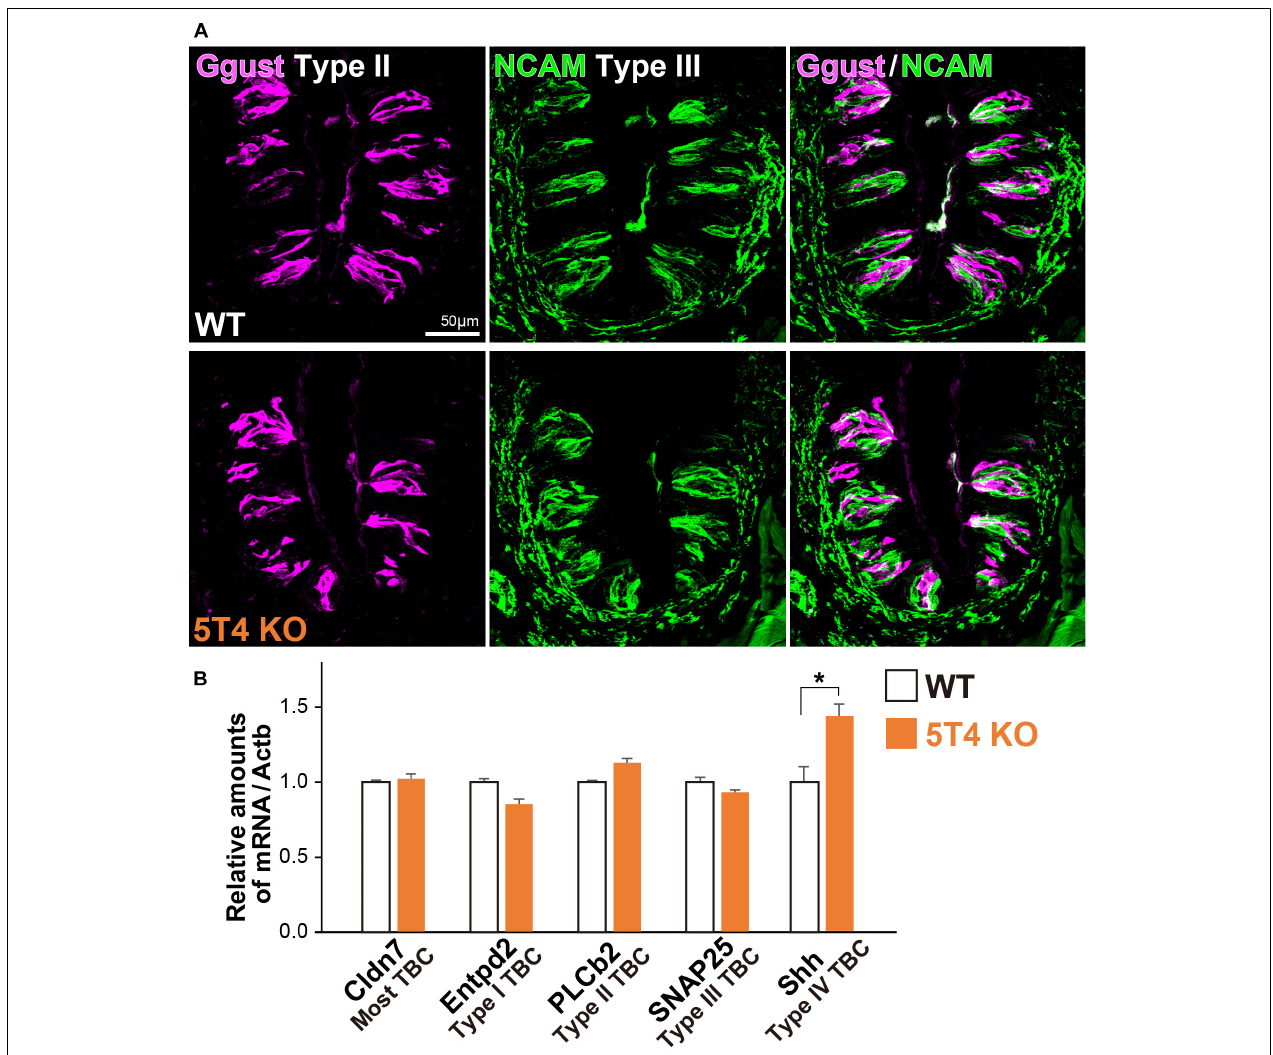
FIGURE 4 | Differentiation of taste receptor cells does not differ between 5T4 -KO and WT mice. (A) IHC of the CVPs from WT and 5T4- KO mice with antibodies against Ggust (a marker of Type II TBCs; magenta) and NCAM (a marker of Type III TBCs; green). Scale bars, 50 µ m. Images are Z-stack projections of seven sections (0.64 µ m/slice). (B) RT-qPCR analysis of total RNA extracted from the CVPs of WT and 5T4 -KO mice. The level of Actb mRNA was used as an internal control ( ∗ p = 0.038 between WT and 5T4 -KO mice, Student’s t test with Bonferroni correction; n = 4 per bar). Note that differentiation of taste receptor cells does not differ between 5T4 -KO and WT mice, but Shh expression (a marker of taste precursor cells) is higher in 5T4 -KO mice than in WT